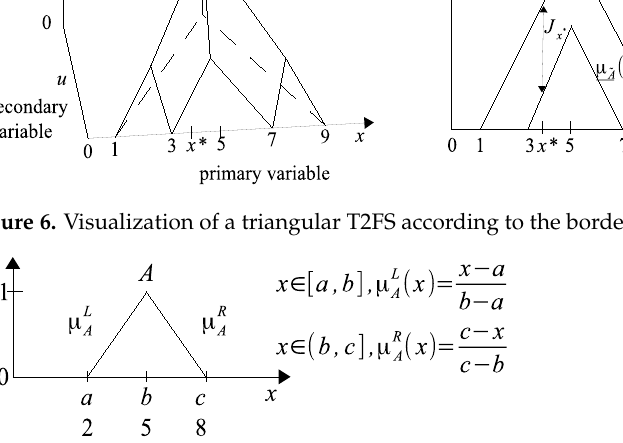
Figure 7. Illustration of the boundary character of membership function of a T1FS according to Zadeh’s first definition of